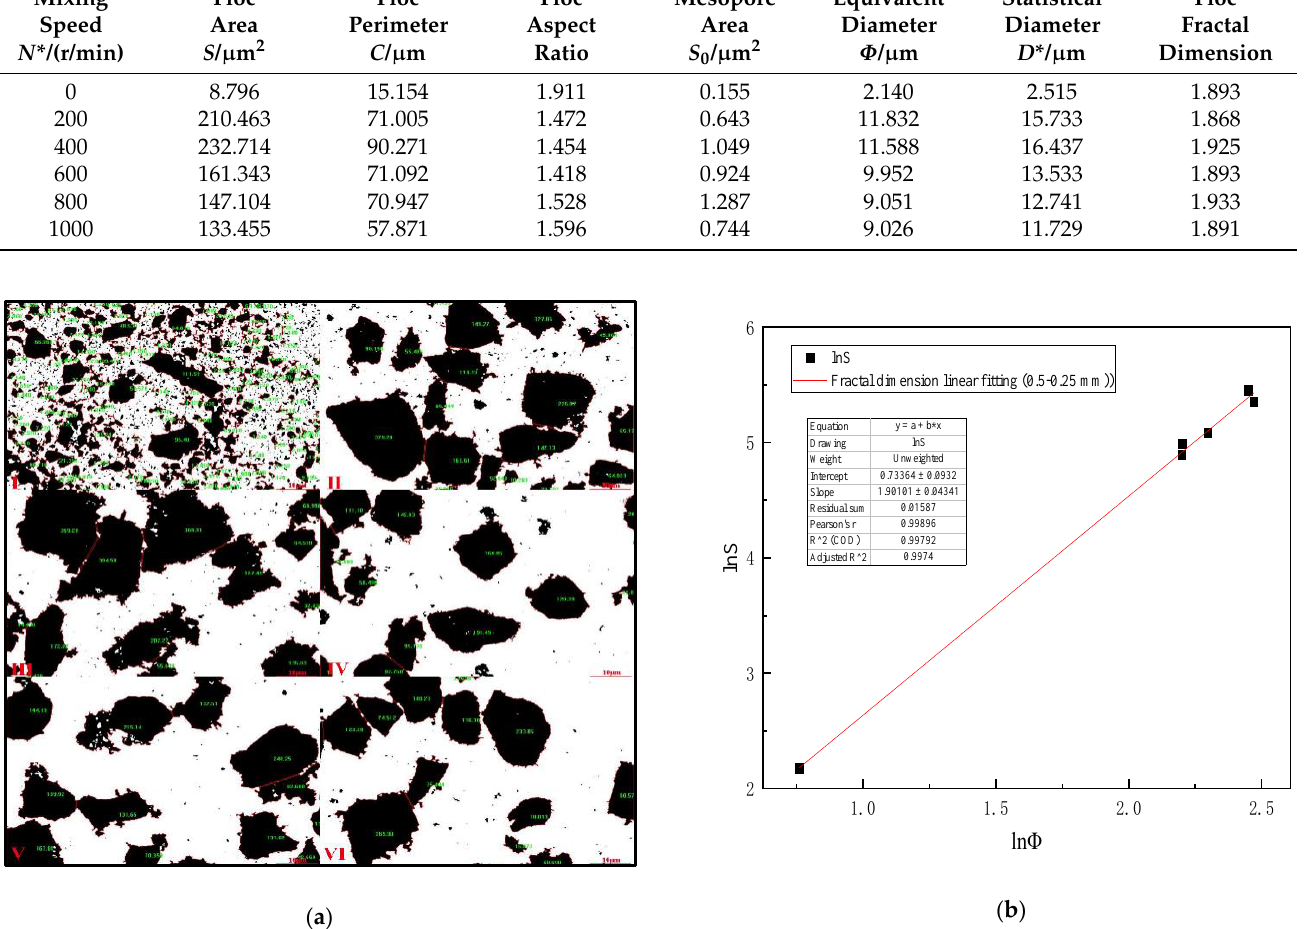
Figure 7. ( a ) Area diagram of 0.5–0.25 mm coal slime floc at different mixing speeds. ( I ) 0, ( II ) 200 r/min, ( III ) 400 r/min, ( IV ) 600 r/min, ( V ) 800 r/min, ( VI ) 1000 r/min; ( b ) Fractal dimension fitting diagram of settling floc of 0.5–0.25 mm coal slime. Table 7 is analyzed by Image-Pro-Plus 6.0 software and (Formulas (15)–(17)), which shows that when the mixing speed is 400 r/min, the equivalent diameter of 0.25–0.125 mm slime settling floc is the largest, and the settling speed of slime floc is the fastest on the microscopic level. Figure 8a is the analysis diagram of floc area of 0.25–0.125 mm slime at the mixing speed of 0–1000 r/min. Figure 8b shows the fractal dimension fitting diagram, when the mixing speed is 0–1000 r/min, the mean fractal dimension of 0.25–0.125 mm coal slime floc is 2.016.